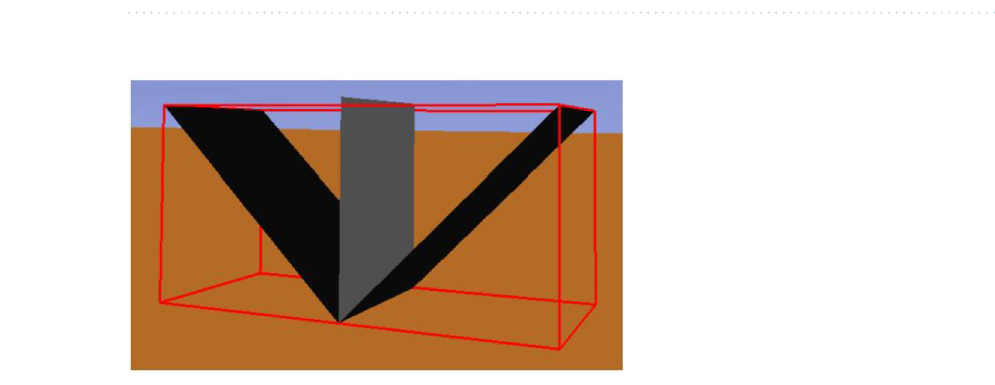
Figure 5. Simulation environment for a parabolic concentrator: receiver on the middle-top of the parabolic concentrator.